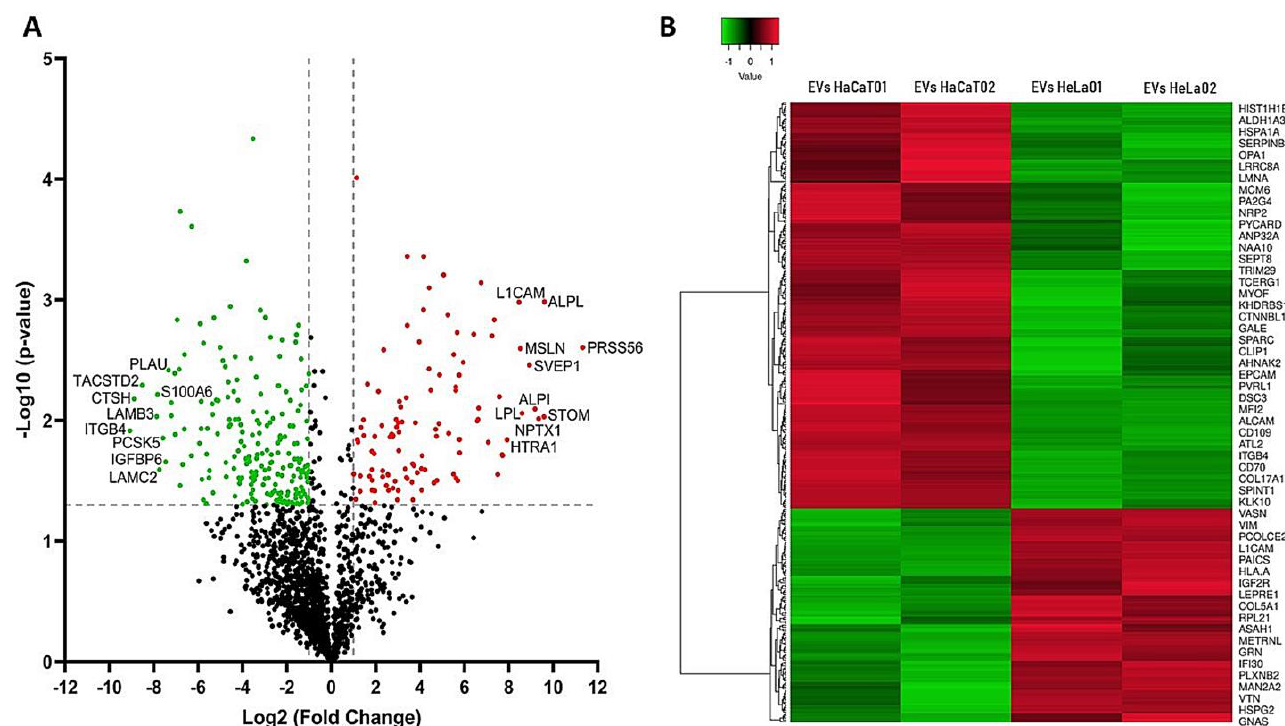
Figure 3. Differentially expressed proteins in EVs: ( A ) volcano plot shows the differentially expressed proteins between cervical cancer EVs (HeLa’s EVs) and control (HaCaT’s EVs). Significantly upregulated proteins (FC ≥ 2) are indicated in red, and significantly downregulated proteins (FC ≤ −2) in green; proteins without significant changes are seen in black. The X-axis shows the level of cervical cancer fold change versus control (base 2 log transformation), and the Y-axis shows the negative logarithm (base 10 log transformation) of the p -value; ( B ) hierarchical clustering heat map of differentially expressed ( p -value < 0.05) upregulated (red) or downregulated (green) proteins in the cervical cancer group compared with those of the control group. HeLa01 and HeLa02 EVs correspond to the two biological replicates of the cervical cancer group; HaCaT01 and HaCaT02 EVs correspond to the two biological replicates of the control group.